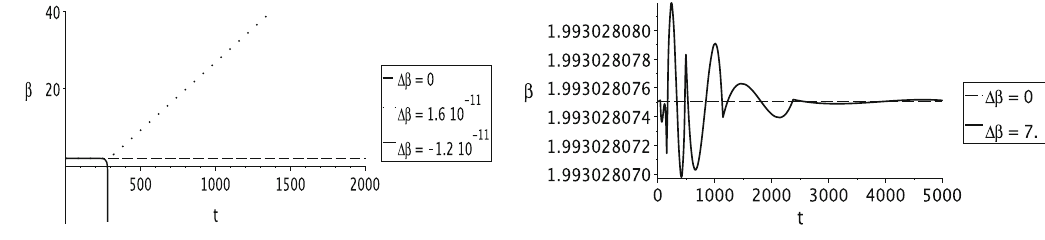
Fig. 4 Numerical solution to the system of equations (8), (9) and (10) for initial conditions α( 0 ) = 150 , β( 0 ) (cid:4) 1 . 9930281 + (cid:10)β, ˙ α( 0 ) (cid:4) 0 . 4046668 , ˙ β( 0 ) = 0 , ˙ R ( 0 ) = 0. R ( 0 ) (cid:4) 2 . 0764993 is found from Eq. (11). The Lagrangian parameters are k = − 2 . 98 , a = − 2 . 77 , c =